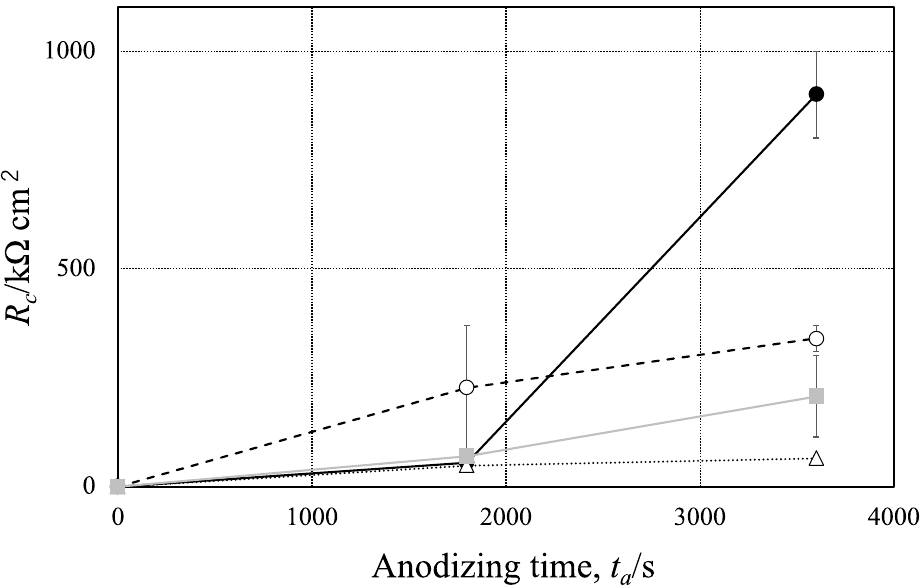
Figure 17. Relationship between solution resistance in cracks, R c , and anodizing time, t a , obtained for pure Al, 1050-Al alloy, 3003-Al alloy and 5052-Al alloy with t p = 1200 s. Anodizing condition is described in Figure 3, and pore sealing condition is described in Figure 9.